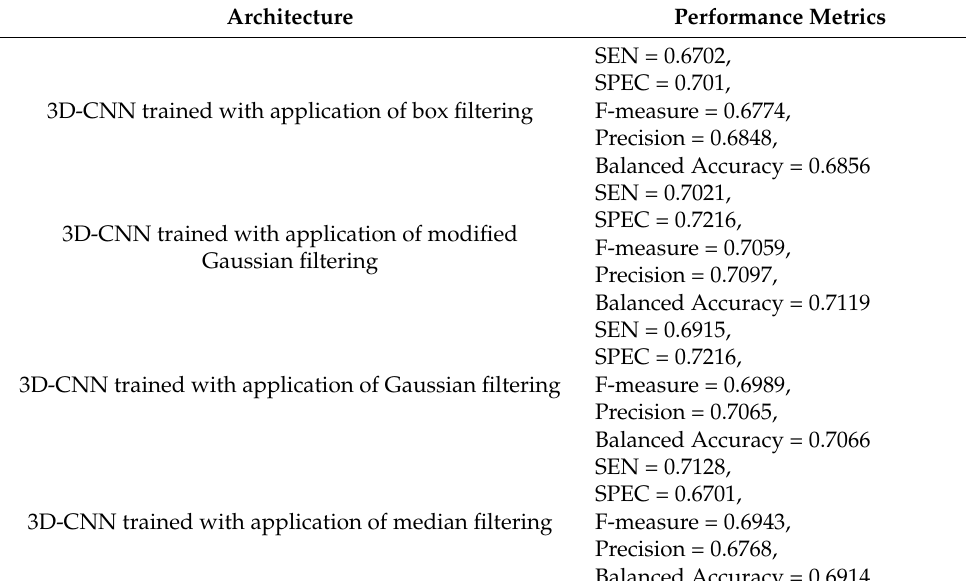
Table 3. Result of binary classification between AD and MCI classes.